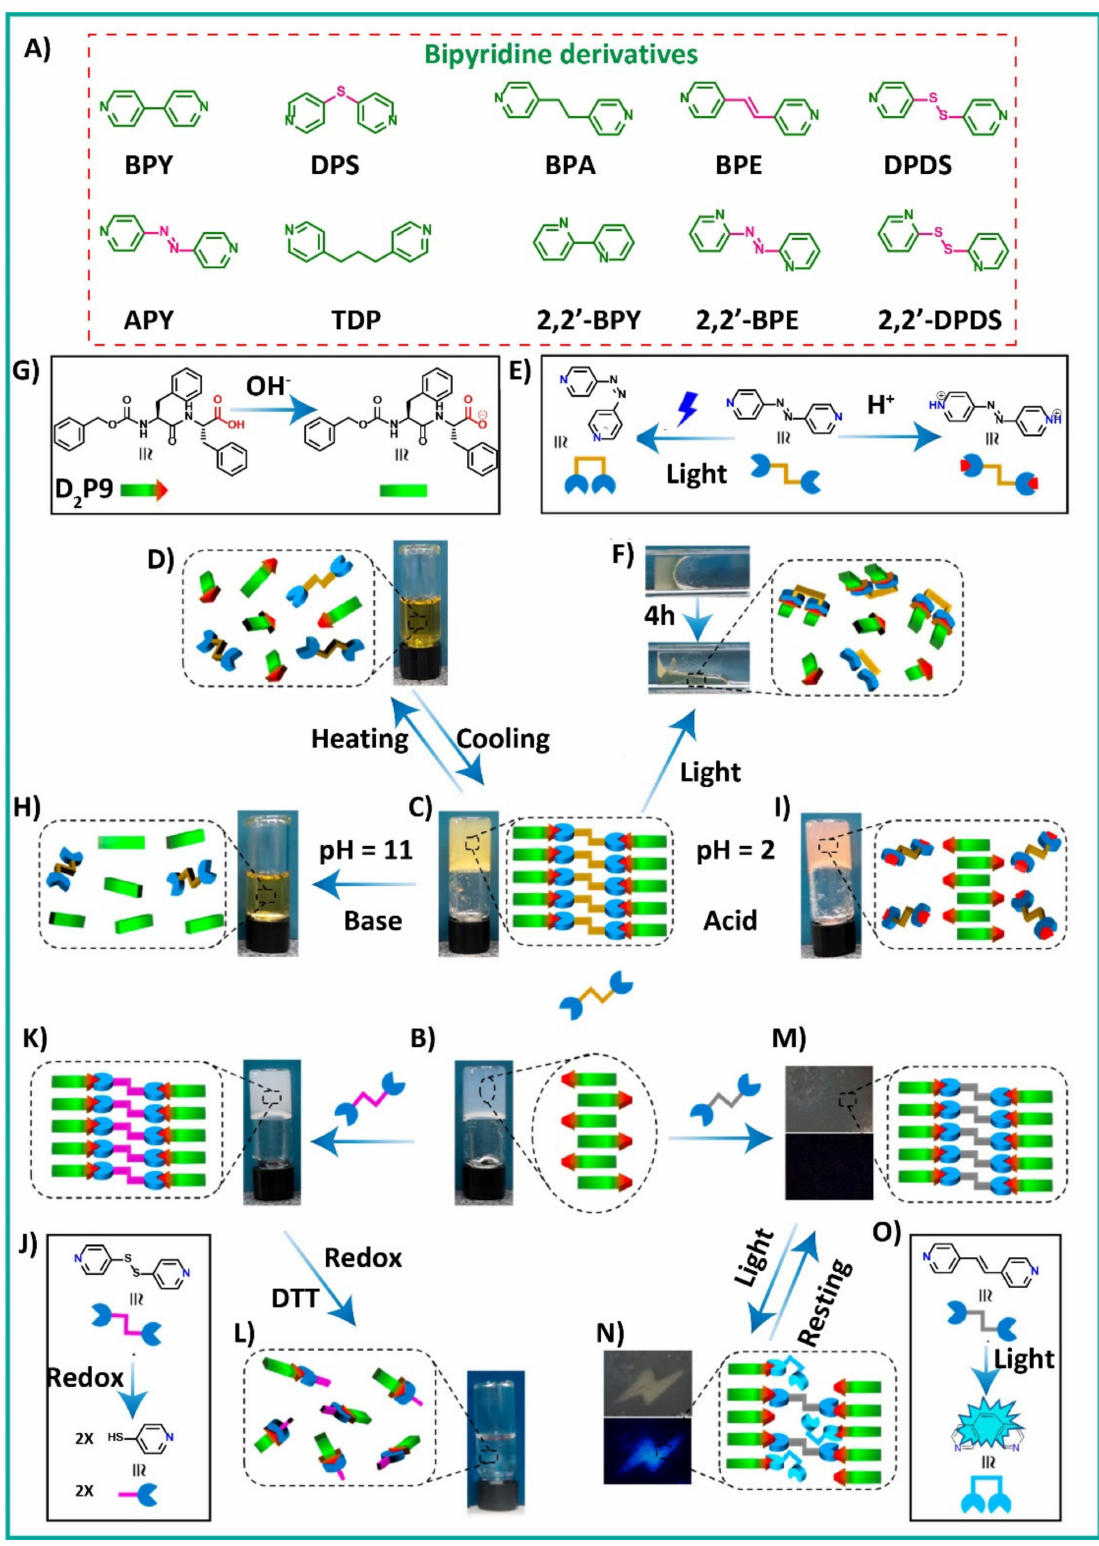
Figure 17. ( A ) Molecular structures of bipyridine derivatives; redrawn from Ref. [98]. Copyright is not applicable here. ( B – O ) Multiple-responsive (pH, redox reagents, light, heat, acid and base) co-assembled hydrogels produced between D 2 P16 and bipyridine derivatives; reproduced with permission from Ref. [98]. Copyright (2021) American Chemical